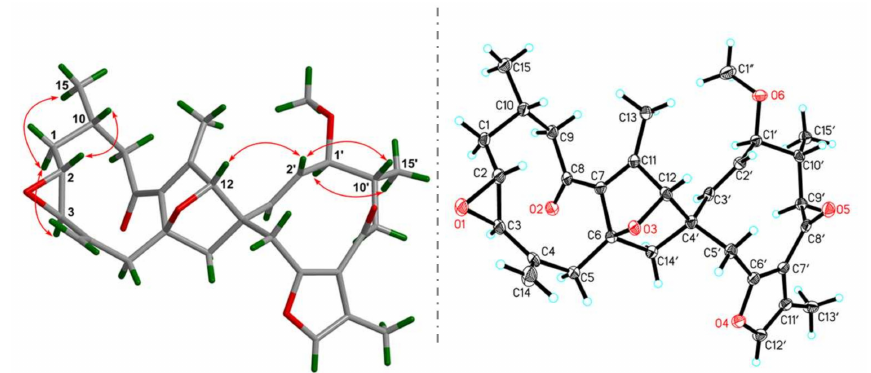
Figure 3. Key ROESY correlations and X-ray crystallographic analysis for 1